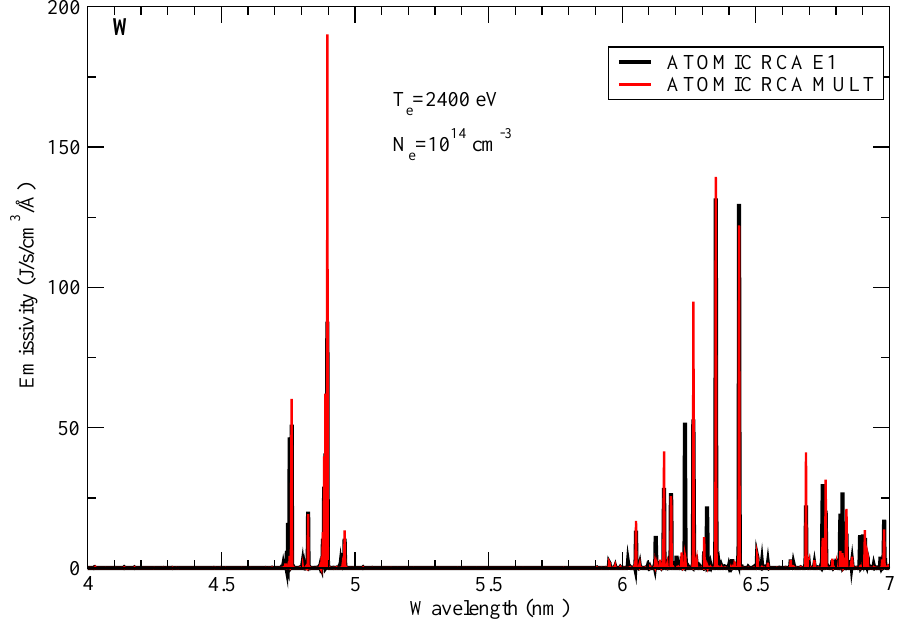
Figure 2. Emission spectrum of tungsten at a temperature of 2400 eV and an electron density of 10 14 cm − 3 . ATOMIC RCA E1 calculations (black curve that includes only electric dipole transitions) are compared with ATOMIC RCA MULT calculations (red curve that includes radiative transitions up to and including